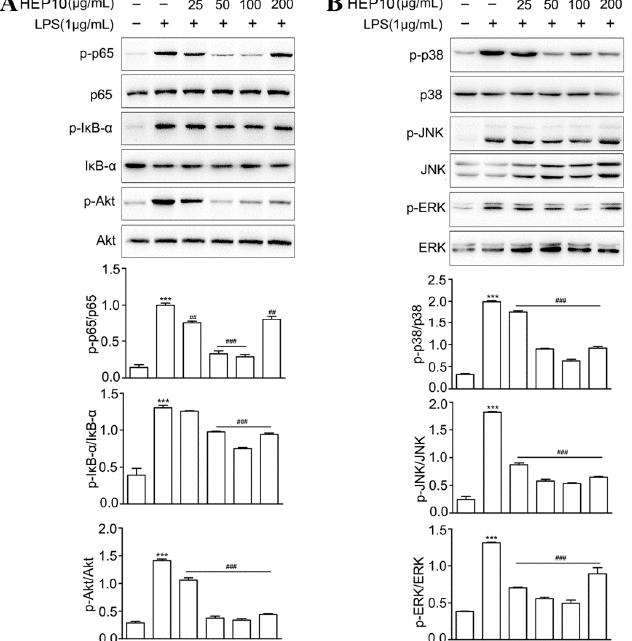
Figure 3. HEP10 inhibited NF- κ B, Akt, and MAPK signaling in LPS-induced RAW264.7 cells. HEP10 (25 − 200 µg/mL) treated for 2 h and followed by LPS (1 µg/mL) stimulation for 24 h. Total cellular